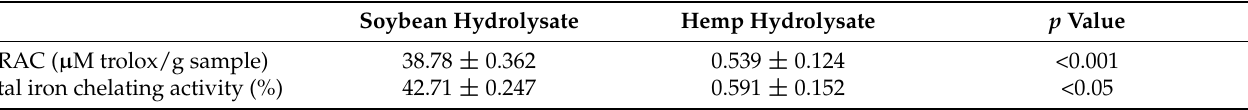
Table 1. In vitro antioxidant assays of soybean and hemp protein hydrolysates. Soybean Hydrolysate Hemp Hydrolysate p Value ORAC ( µ M trolox/g sample) 38.78 ± 0.362 Metal iron chelating activity